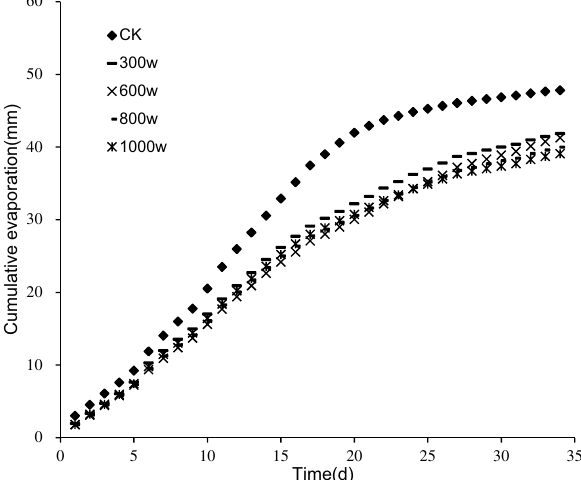
Figure 8. Cumulative evaporation of iron tailings for four molecular weight (300w, 600w, 800w and 1000w) and mass concentration with 0.16% of